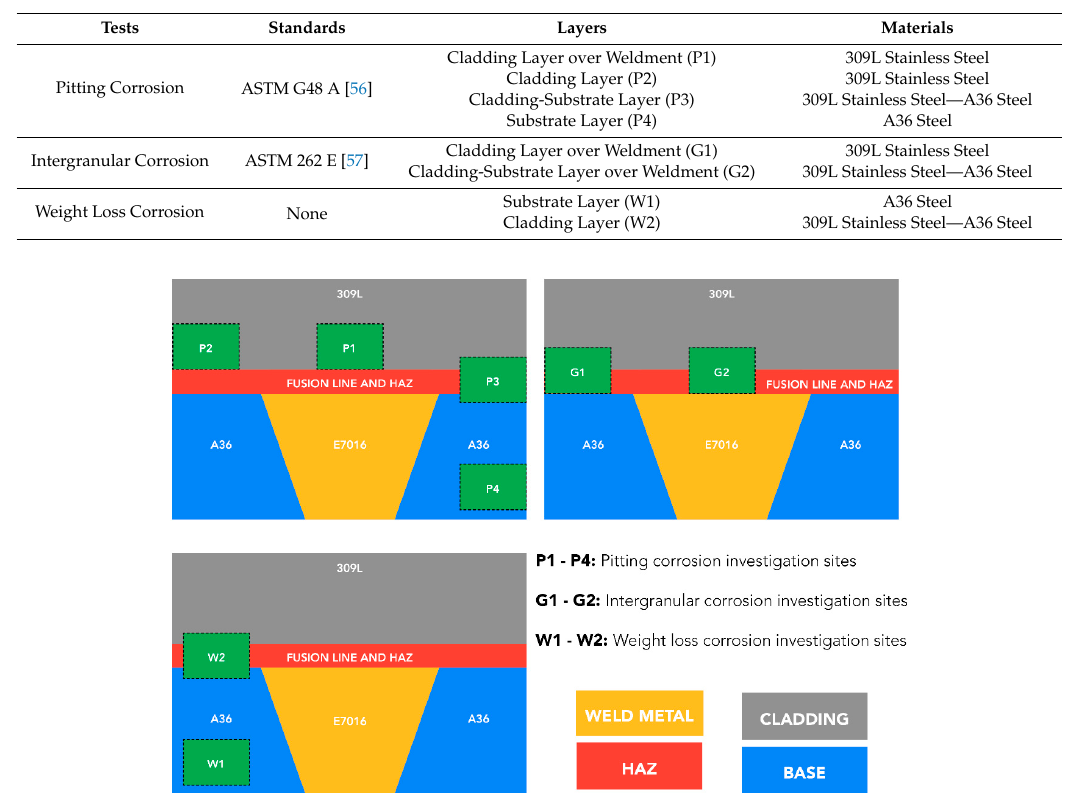
Figure 6. The investigated sites for the corrosion tests.